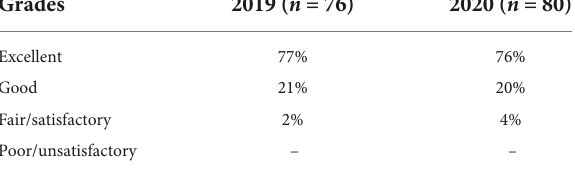
TABLE 3 Final exam results at master level.